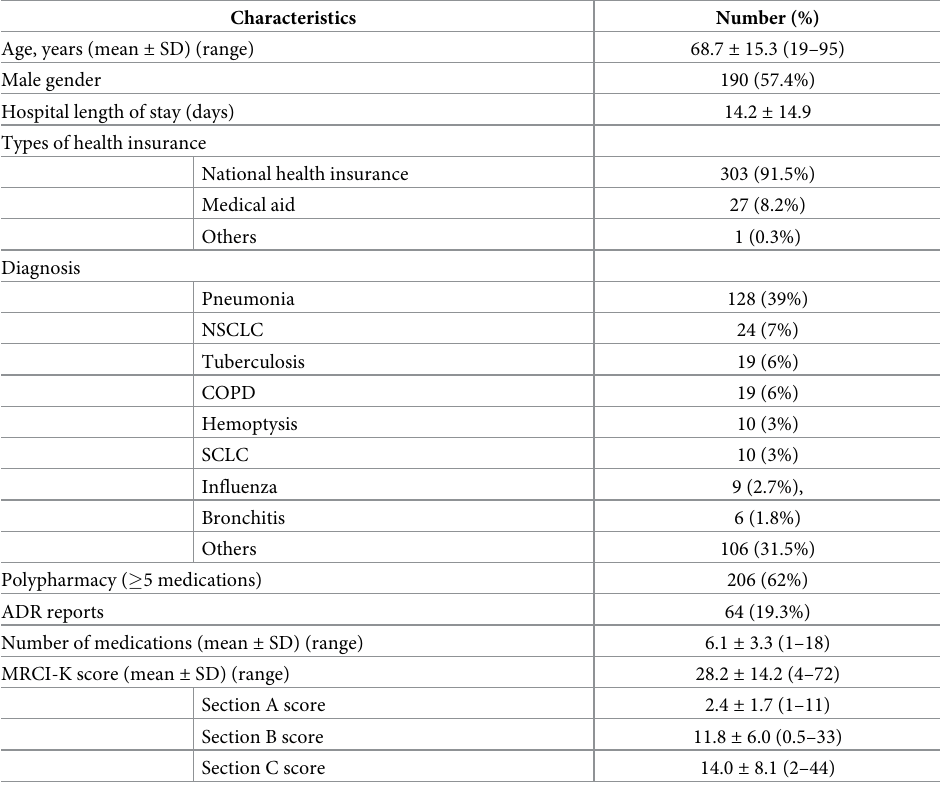
Table 1. Baseline characteristics of the patients included in the analysis (n =